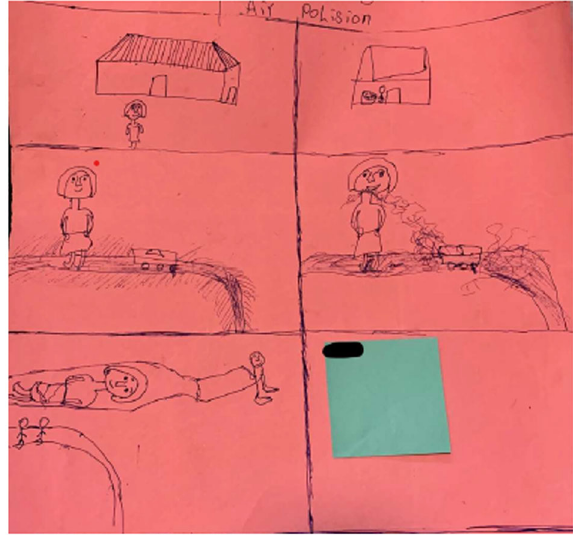
Fig. 6 Example of a picture drawn by a child attending school in Mukuru when asked to draw a story depicting their experiences of air